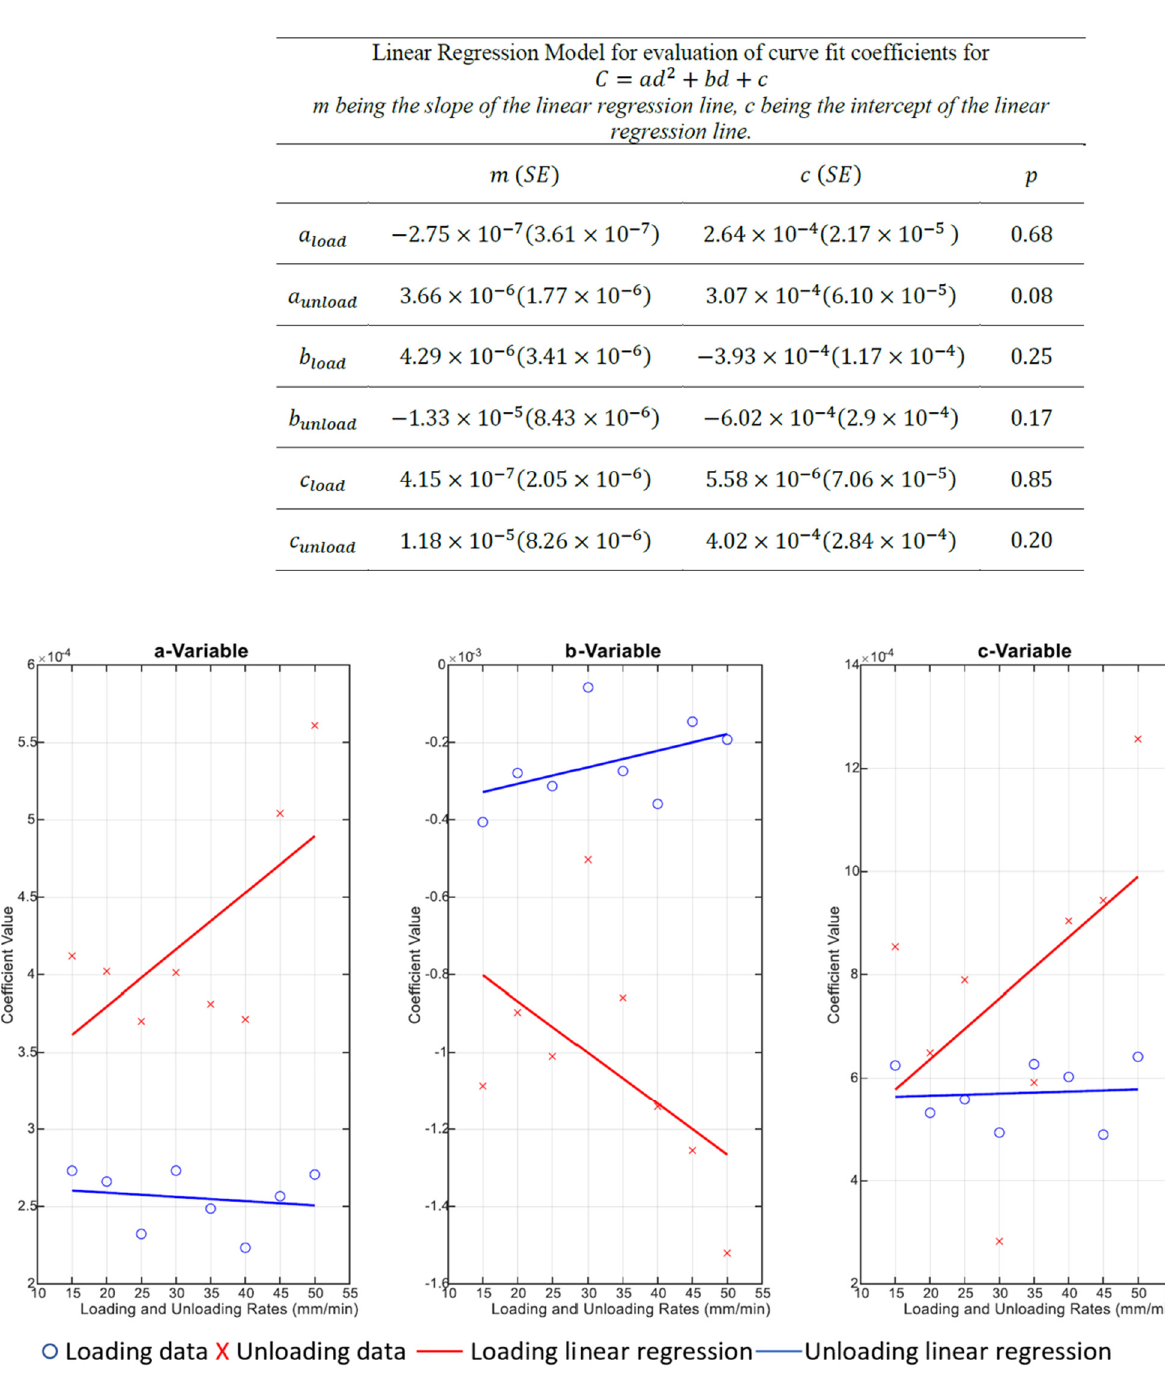
Figure 23. Plot of mean Values from Figure 20 with a fitted linear regression model.